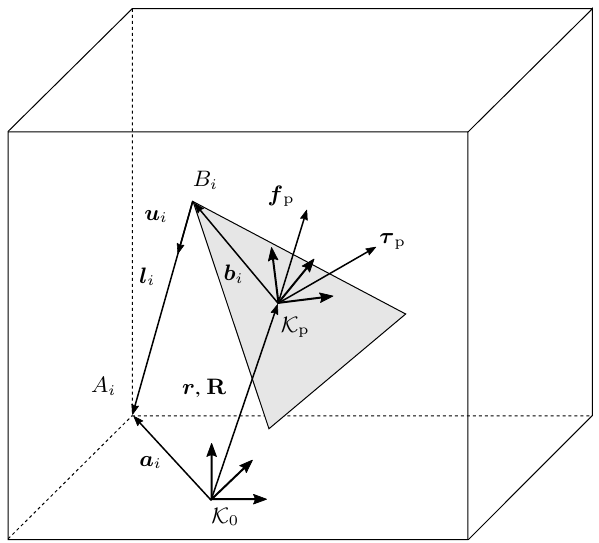
Figure 2. General kinematic parameters.